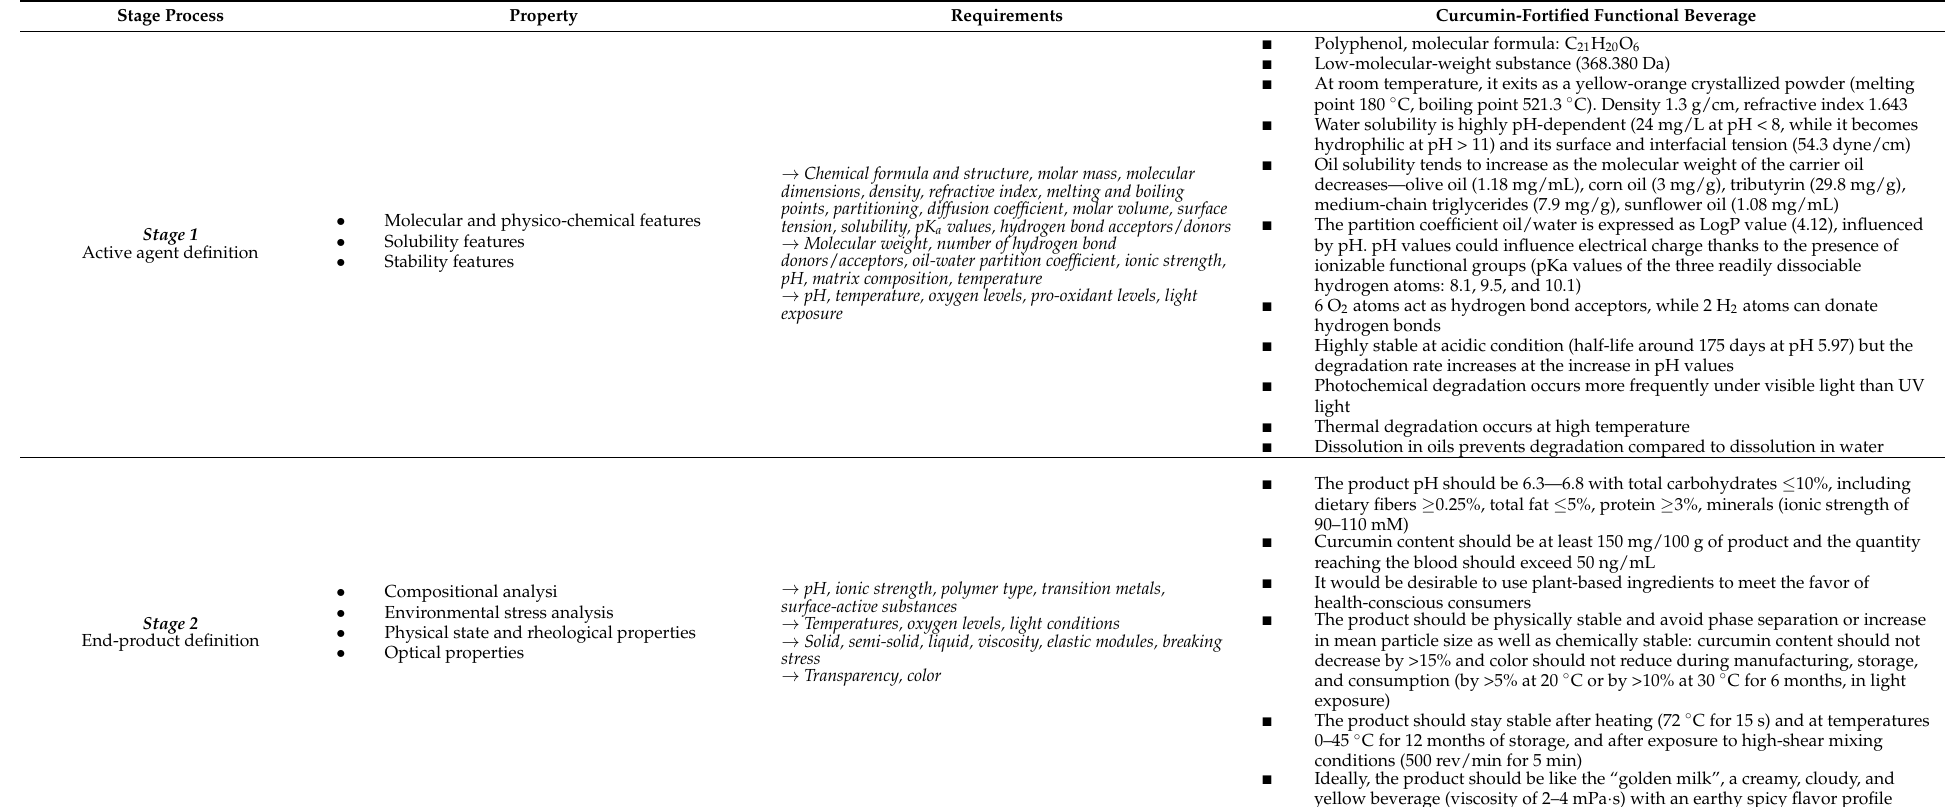
Table 3. A detailed step-by-step description of the DbD approach with an overview of curcumin-fortified beverages